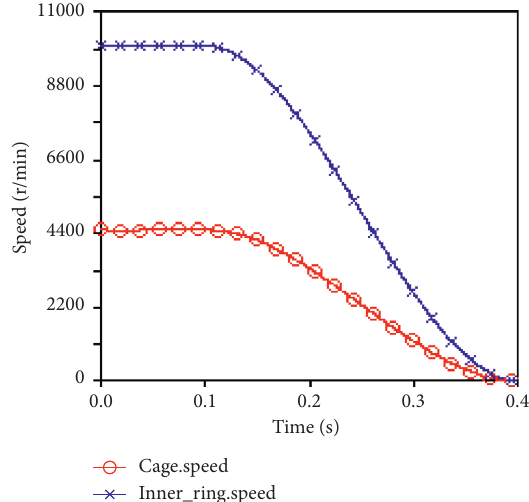
Figure 6: Speed of inner ring and cage at the stage of stop.